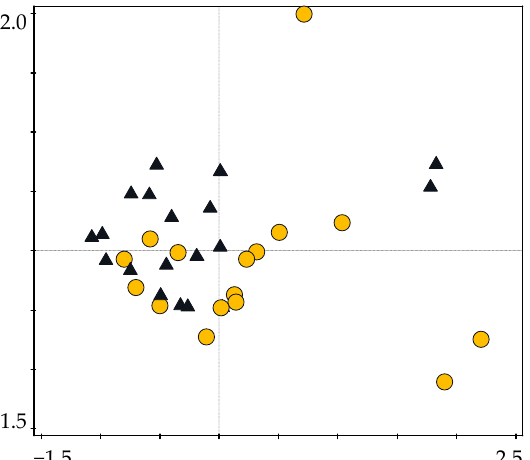
Figure 9. PCoA summarized the beetle species similarity/dissimilarity by independent factor. Yellow circle—sunny trees and black triangle—shady trees.